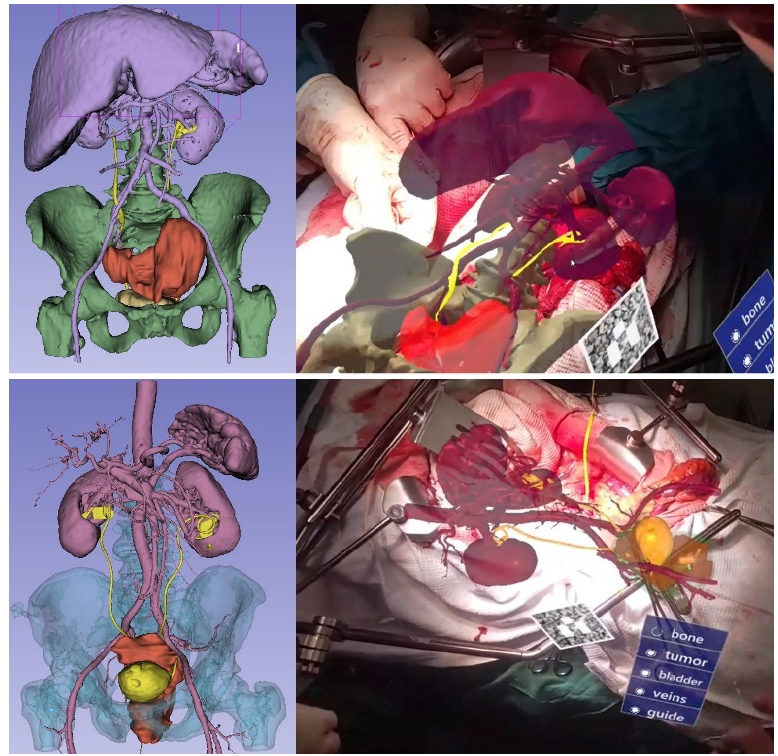
Figure 8. 3D model of the patient anatomy reconstruction and its overlay during the operation.